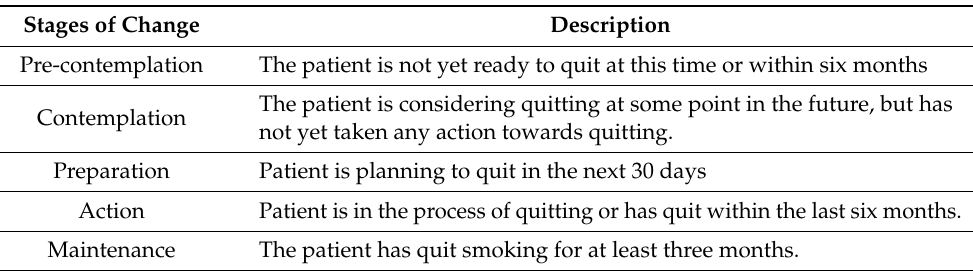
Table 2. Stages of behavior change